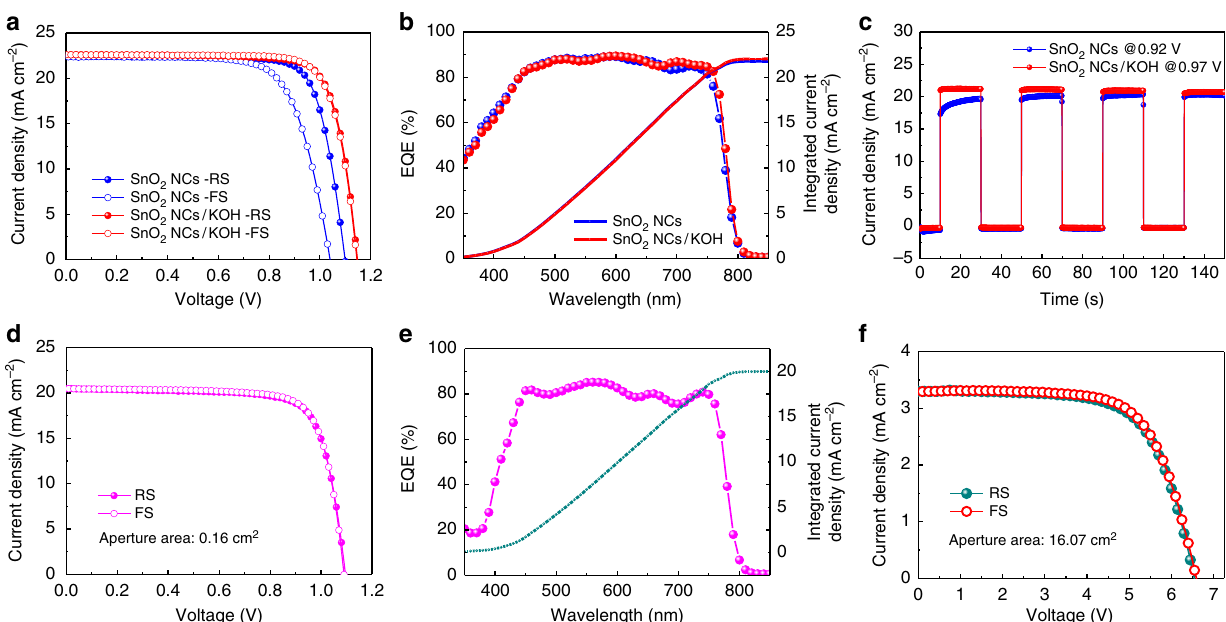
Fig. 3 Performance of PSCs with interface potassium passivation. a The champion J-V curves of SnO 2 NCs-based PSCs with potassium passivation or not. b The corresponding EQE spectra of these champion devices. c Steady-state output current under maximum power point with regularly turn on/off test. d The champion J-V curves of SnO 2 NCs-based fl exible PSC with potassium passivation. e The corresponding EQE spectra of this champion fl exible device and f the J-V curves of SnO 2 NCs-based large-area fl exible